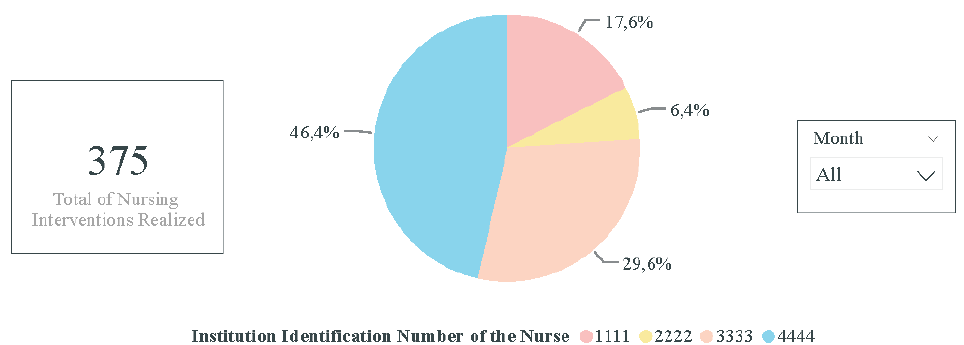
Figure 4. Indicator of the percentage of nursing interventions realized per nurse (created with fictitious